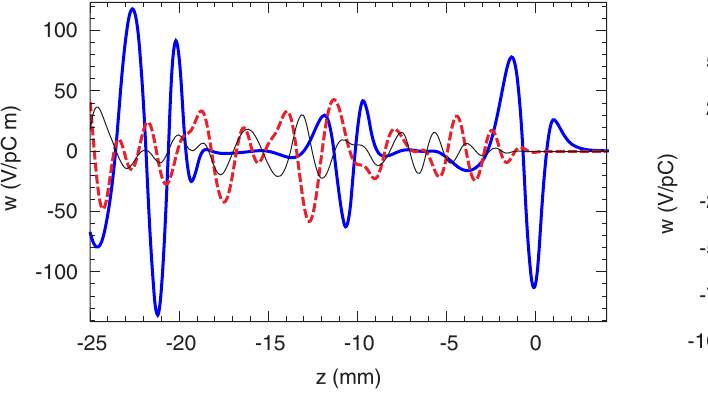
FIG. 10. (Color) Integrated wake for the case A ¼ 3 and b ¼ 2 cm and three lengths of the toroidal segment: 5 (blue line), 10 (broken red line), and 20 (thin black line)